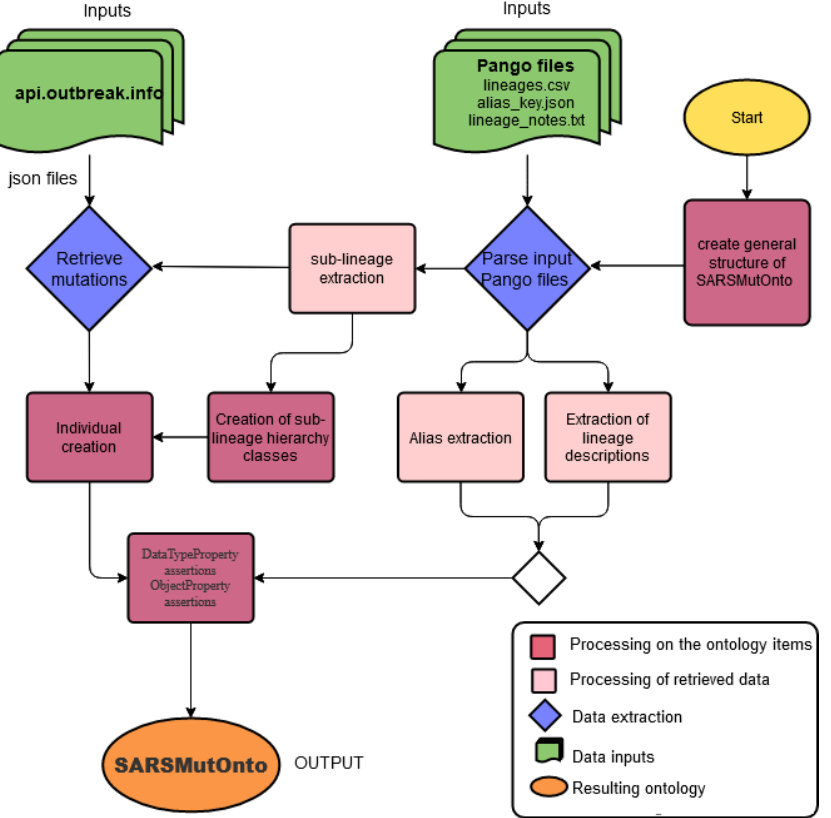
Figure 3. Workflow diagram of the steps followed in this